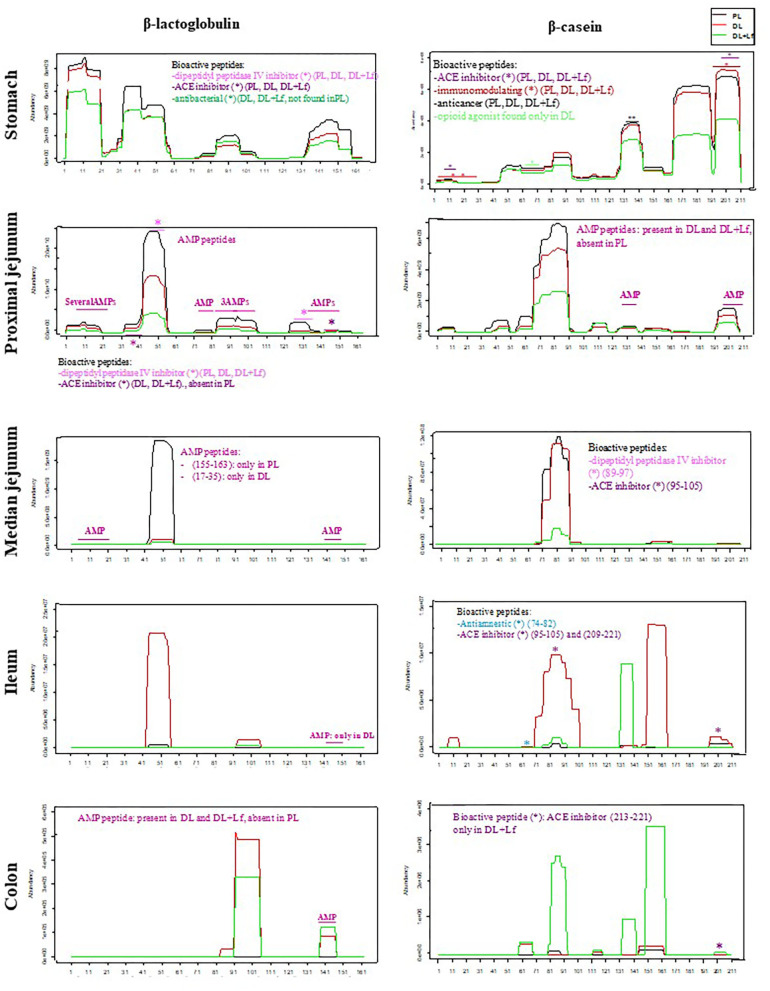
Abundance of peptides belonging to β-lactoglobulin (BLGA) and β-casein (CSN2A2) proteins and identification of bioactive peptides and AMPs throughout the gastrointestinal tract. Bioactive peptides and AMPs are identified by a star colored according to their predicted bioactivity. Formulas contained as lipids either only plant lipids (PL, n = 5–8), a half-half mixture of plant and dairy lipids (DL, n = 5–8), or a half-half mixture of plant and dairy lipids supplemented with Lf (DL+Lf, n = 6–7). A * indicates bioactive peptide or AMP peptides. AMP, antimicrobial peptide; ACE, angiotensin-converting enzyme.